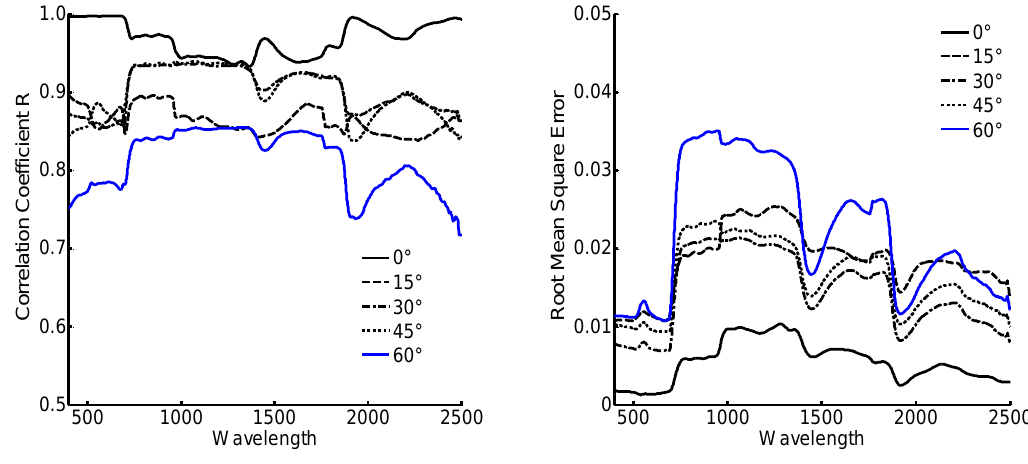
Figure 6. Correlation Coefficient R (left graph) and Root Mean Square Error (right graph) between measured and RPV reflectance for different light source zenith positions.